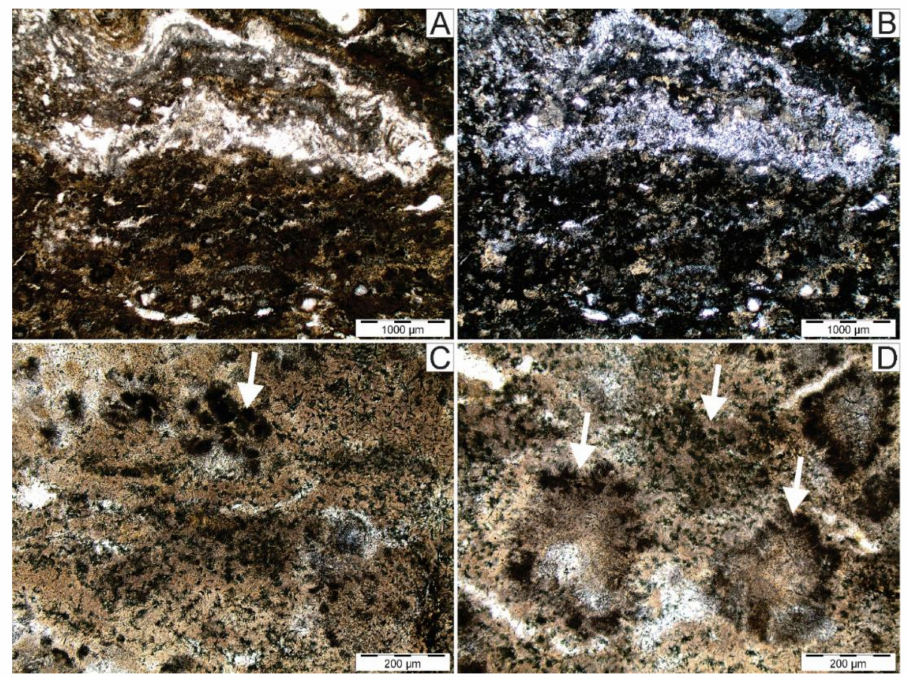
Figure 3. Transmitted light optical images of the PT vein. ( A ) Vein’s matrix (dark), with spherulitic texture and a plastically deformed fragment of quartz, PPT. ( B ) Same area as in ( A ), XPL. The deformed fragment exhibits mosaicism. ( C ) Matrix of PT vein, texturally inhomogeneous, with dark spherules 10–50 µ m in diameter (arrow), PPL. ( D ) Matrix of PT vein, with dark spherules / rings 100–300 µ m in diameter (arrows), PPL. Opaque needles are visible in ( C , D